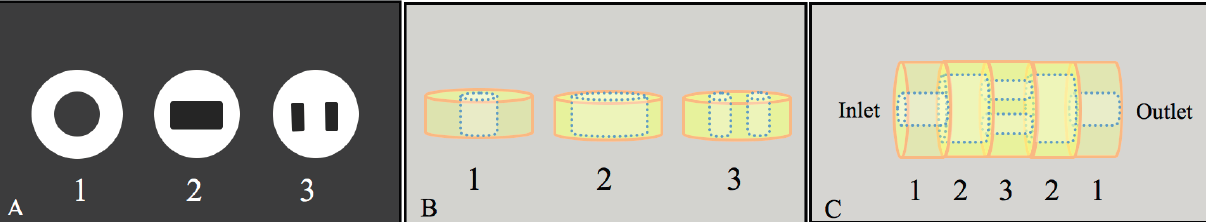
Figure 6. Modular method for fabricating multi-level tubular constructs. ( A ) The Mask with multi-level tubular structure for a photopatterning approach; ( B ) The microtubes created after UV-light photocuring; ( C ) Microtubes are assembled into a larger and longer tubular construct with multi-level interconnected